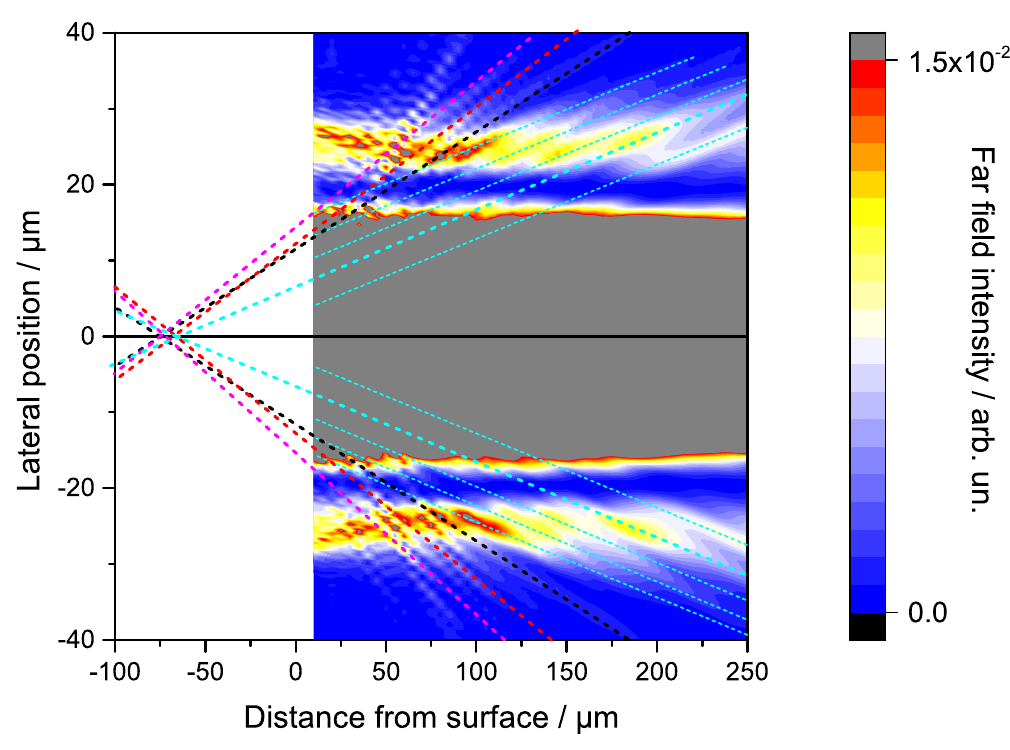
Figure 7. Simulated far-field distribution map E 2 ( x , y = 0, z ) as function of distance from the sample surface which is located at z =